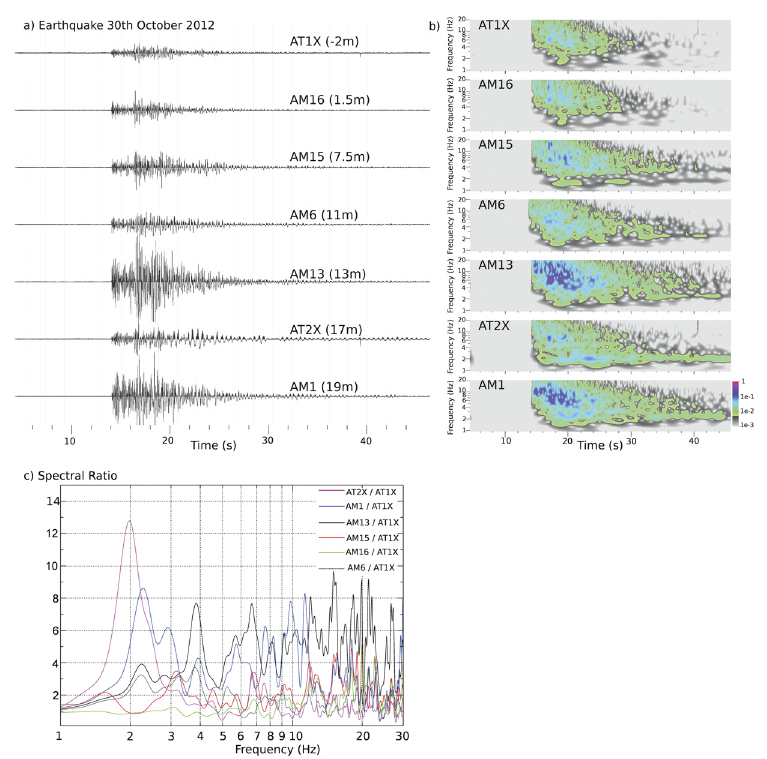
Figure 10. Acceleration of the M 3.6 earthquake of 30 th October 2012 (see also Fig. 9a); the time series are scaled at the same y- amplitude. b) Time-frequency analysis. c) Spectral ratio of the time-series shown in panel (a), assuming as reference site the station